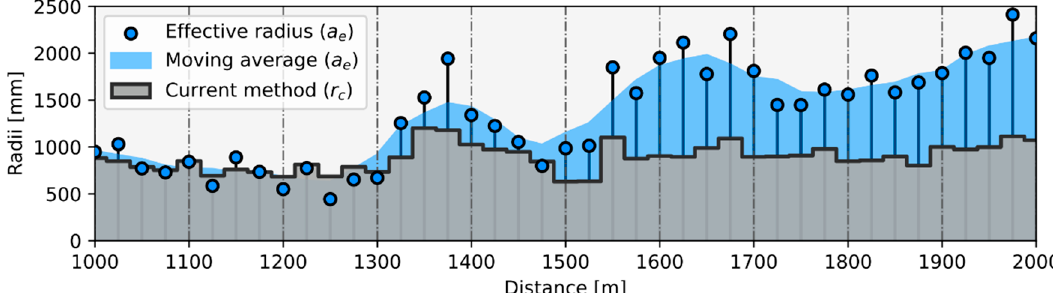
Figure 21. Profile of inertial point ( 𝑟 (cid:3030) ) radius and effective radius ( 𝑎 (cid:3032) ) along the test section.